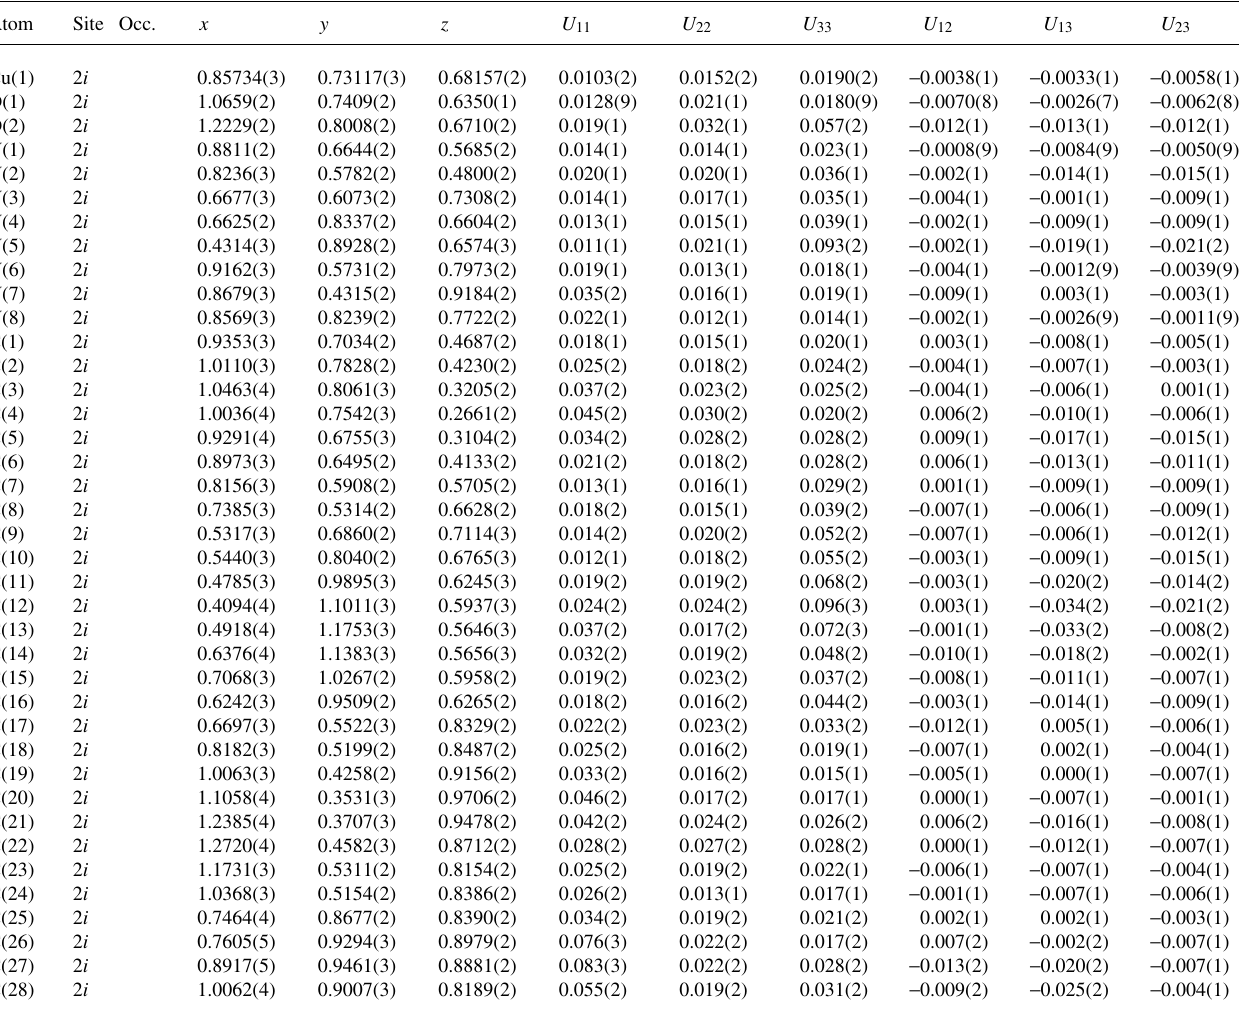
Table 3. Atomic coordinates and displacement parameters (in Å 2 ) .